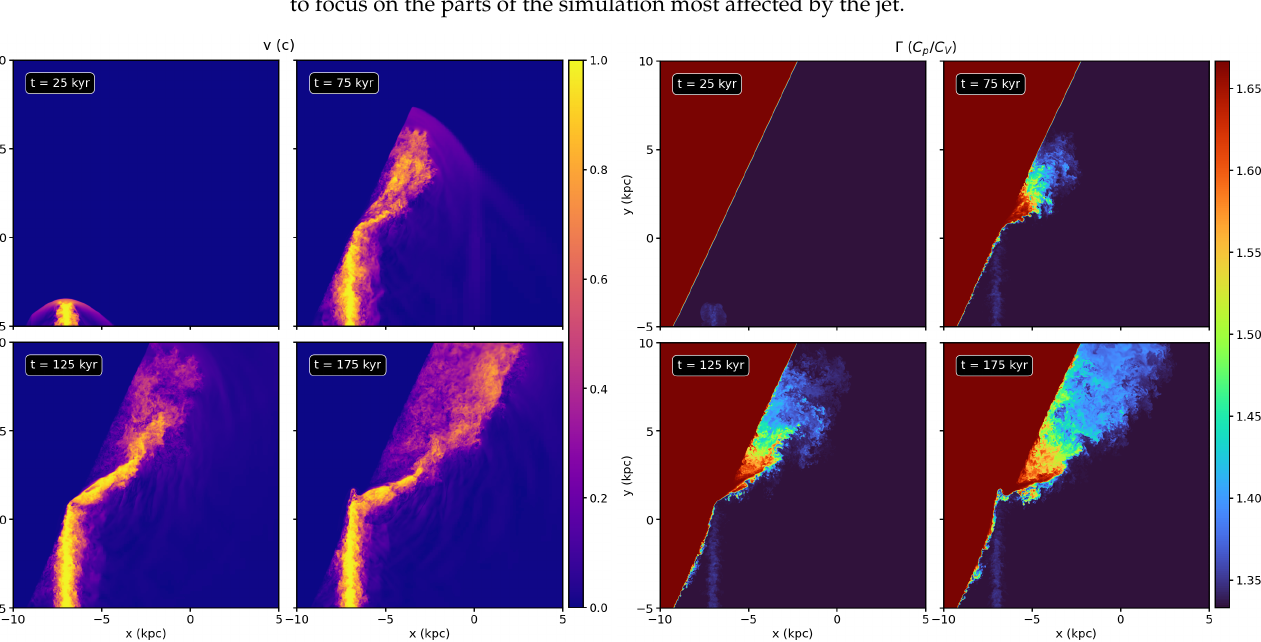
Figure 4. Velocity magnitude ( left ) and ratio of specific heats, Γ , ( right ) on slices through the center of the simulation domain for the “fiducial” simulation, at four different epochs. Each panel is 15 kpc on a side, zoomed in slightly to focus on the parts of the simulation most affected by the